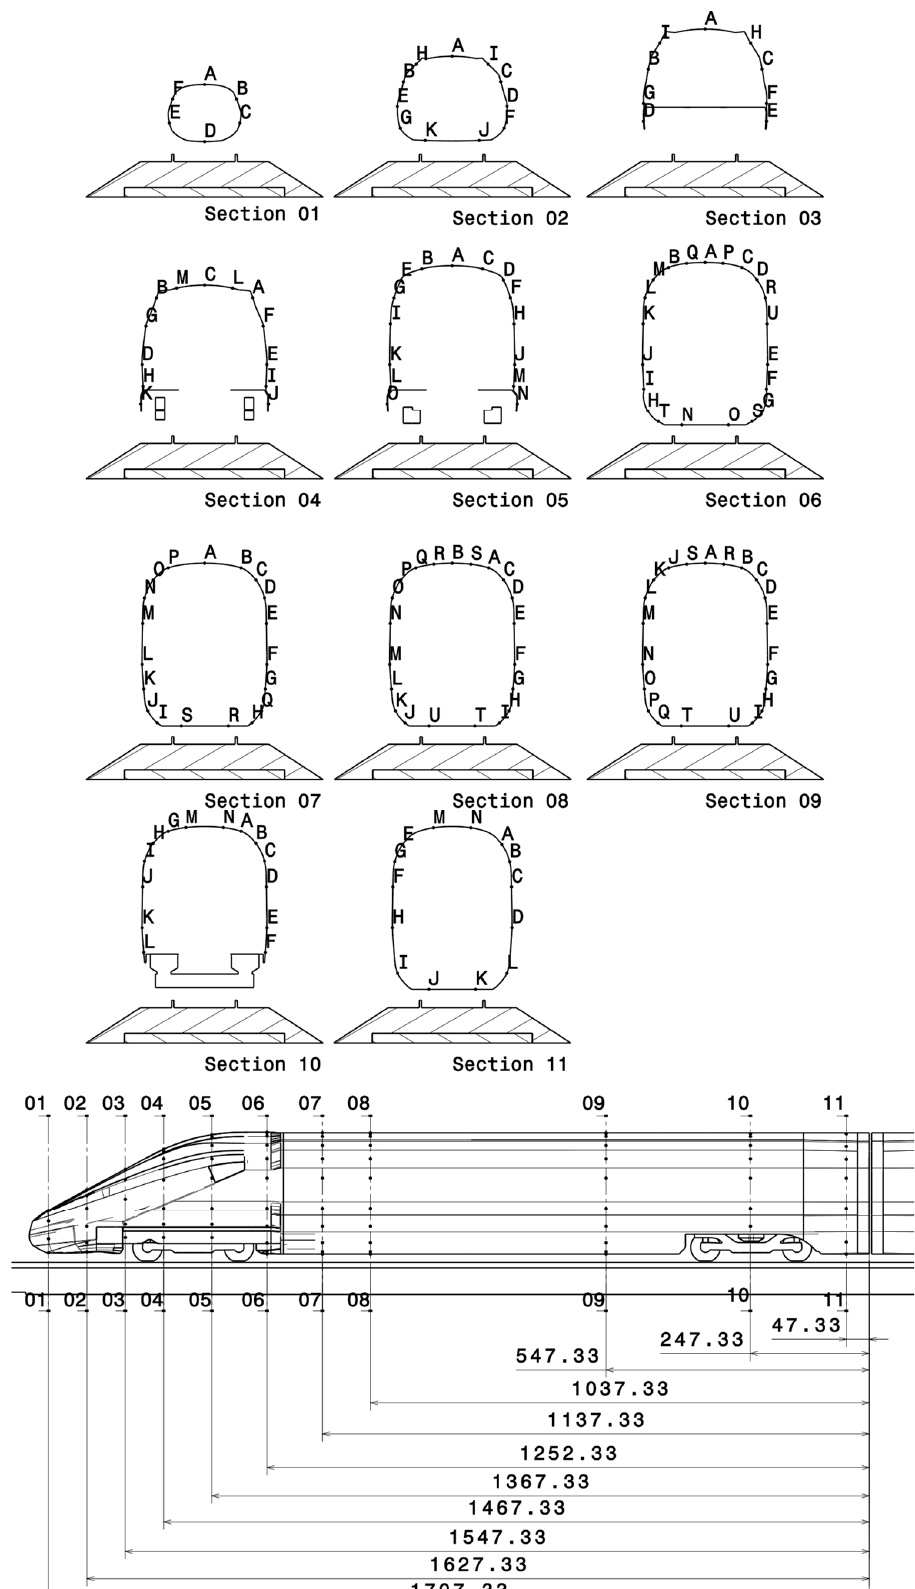
Figure 4. Pressure taps location (quotes in mm).